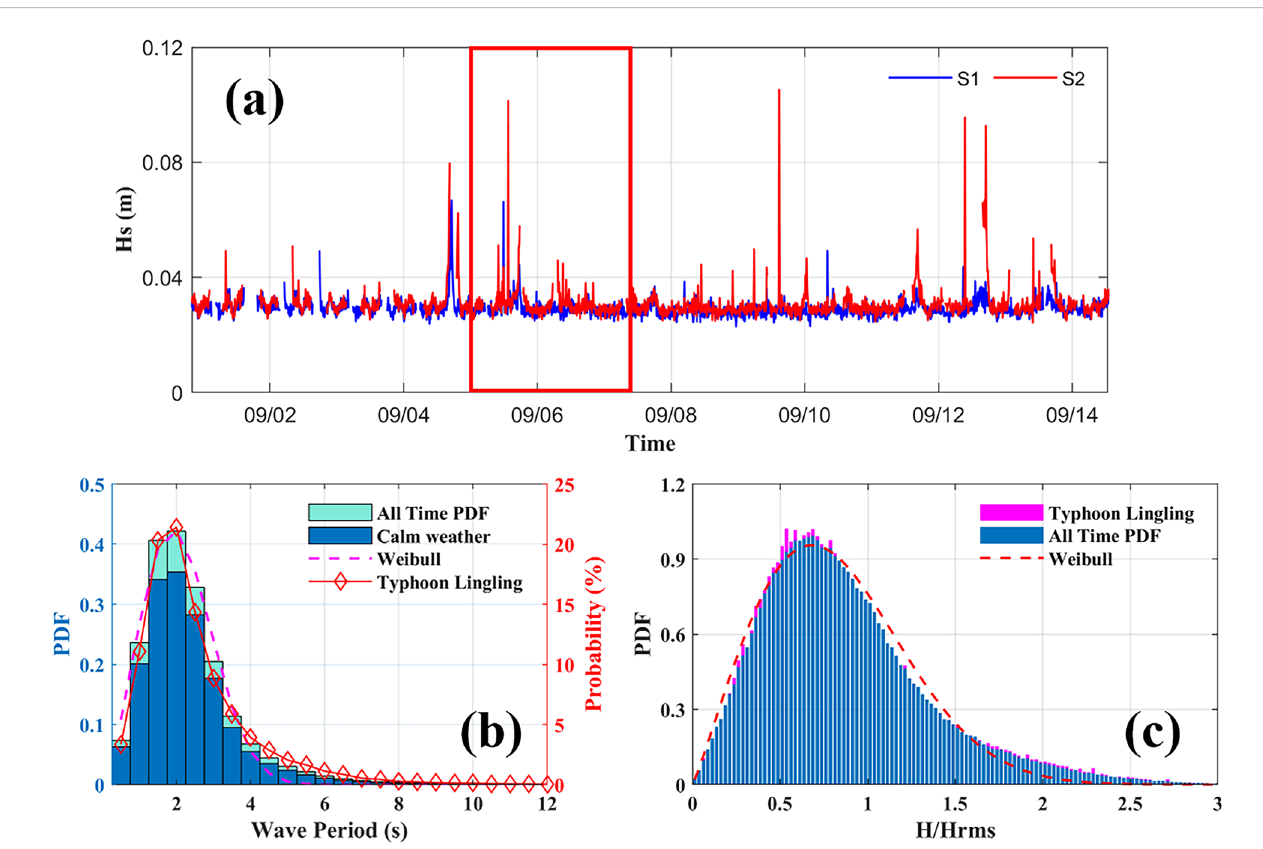
FIGURE 6 (A) Hs time series at stations S1 (blue lines) and S2 (red lines) calculated using ADV data (red box indicates the typhoon period). (B) Histogram of wave periods and (C) H / Hrms , and the fi t of their probability distribution using Weibull distribution function (red lines) at station S1 (RBR data). The probability density of wave periods in calm weather and all time is represented by the blue and cyan histograms in (B) , respectively. The wave period distribution during Typhoon Lingling is shown by the red diamond line. Hrms is the root mean square of the wave heights